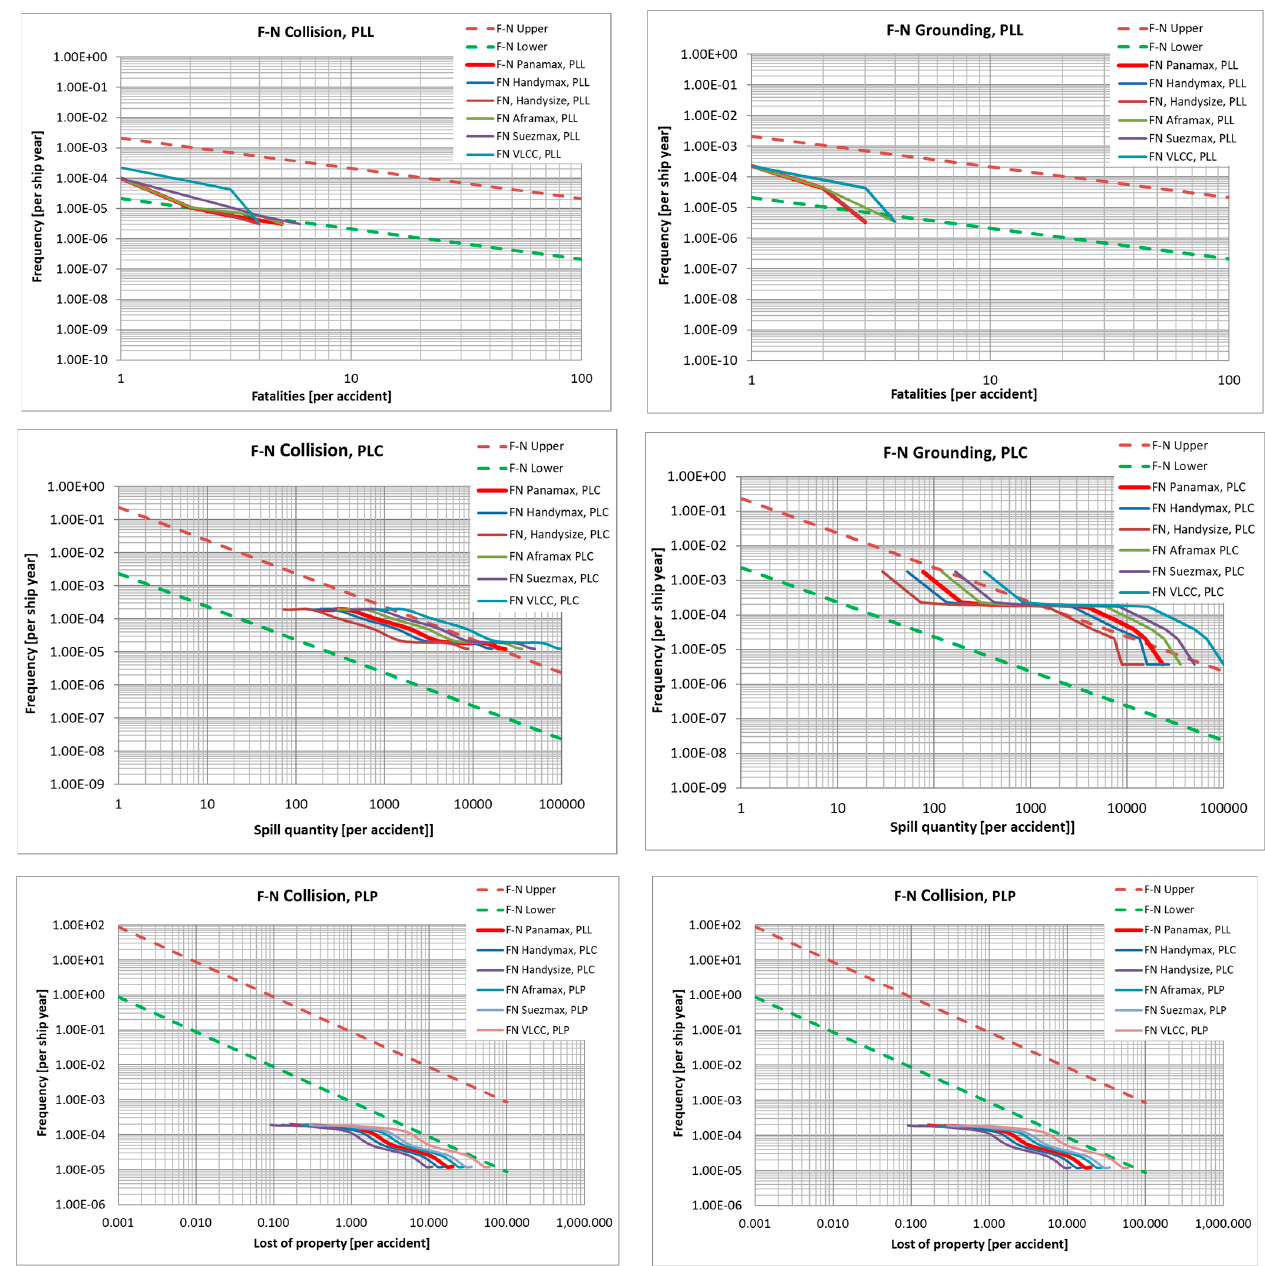
Figure 7. Collective risks level based on tanker category for 2020.